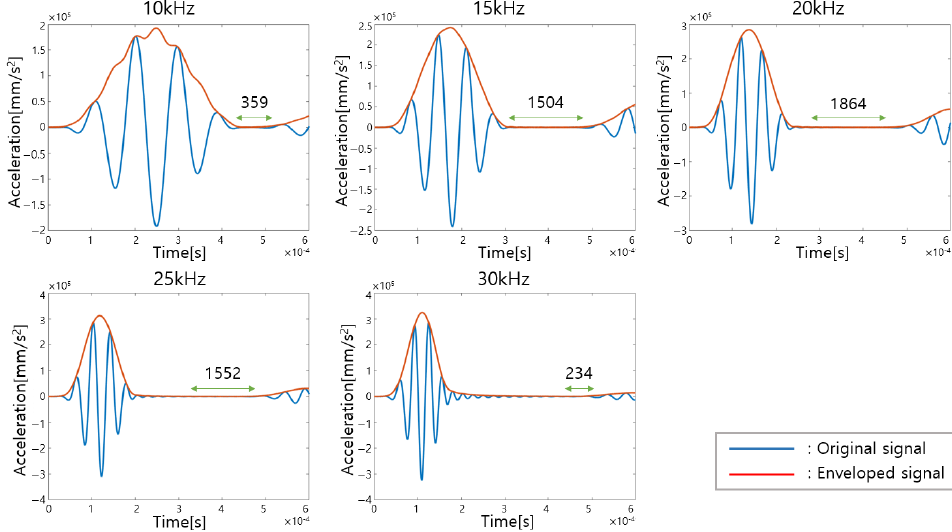
Figure 6. Time interval between direct incident wave and boundary-reflected wave according to excitation frequencies.